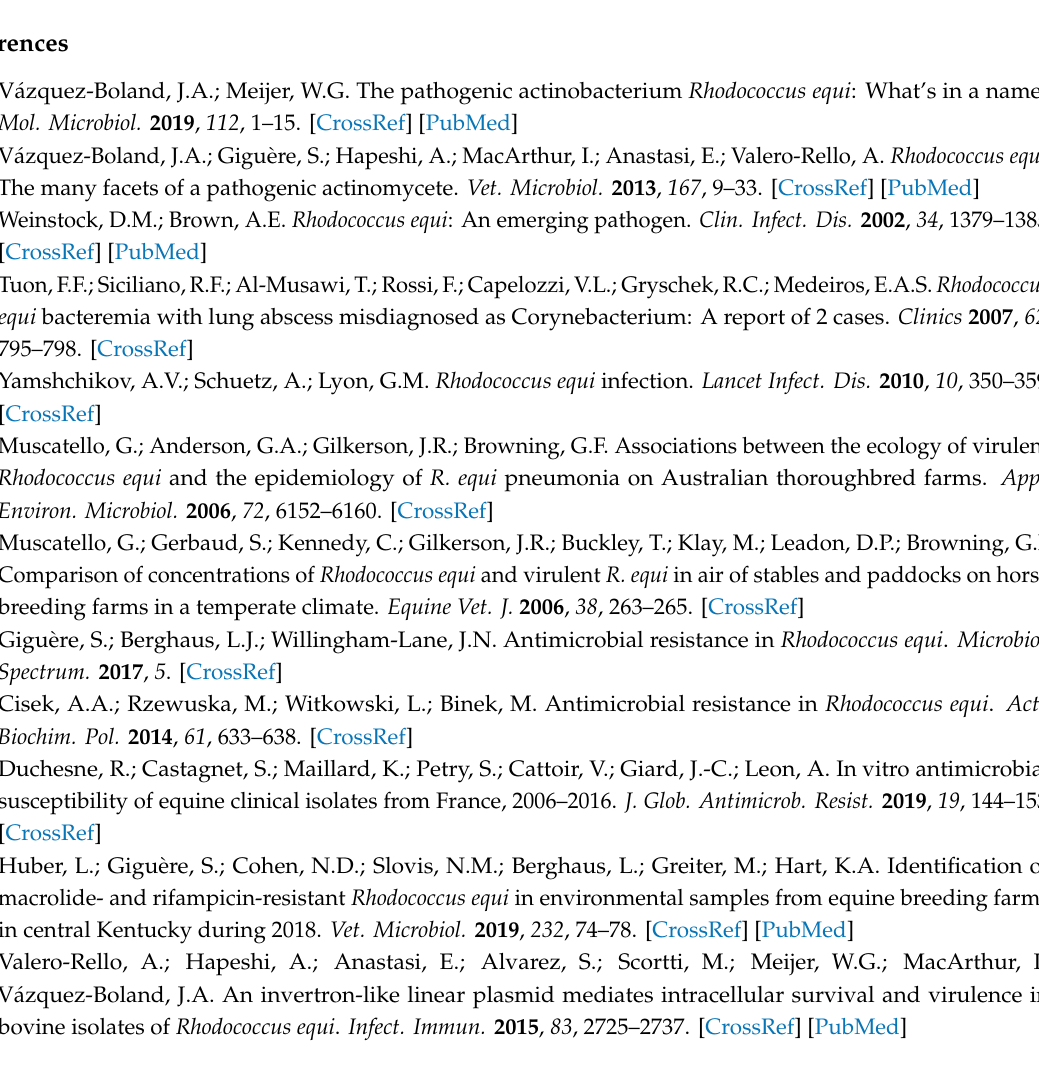
s1, Figure S1: Multiple alignments of the Mrx proteins from di ff erent actinobacteria, Figure S2: Unrooted evolutionary distance tree based on amino acid identity of putative mycoredoxins from di ff erent actinobacteria, Figure S3: Artemis comparison tool (ACT) pairwise chromosome tBLASTx alignment of mycoredoxins in di ff erent actinobacteria, Figure S4: Artemis comparison tool (ACT) pairwise chromosome tBLASTx alignment of mycoredoxins in R. equi and Rhodococcus erythropolis , Figure S5: Growth curve of 103S + and mrx -null mutants strains cultured in TSB, Figure S6: Macrophage infection assays with single and double mrx -null mutants, Figure S7: Total fluorescence emitted by R. equi derivative strains expressing roGFP2 , Table S1: Strains and plasmids used in this study, Table S2: Primers used in this